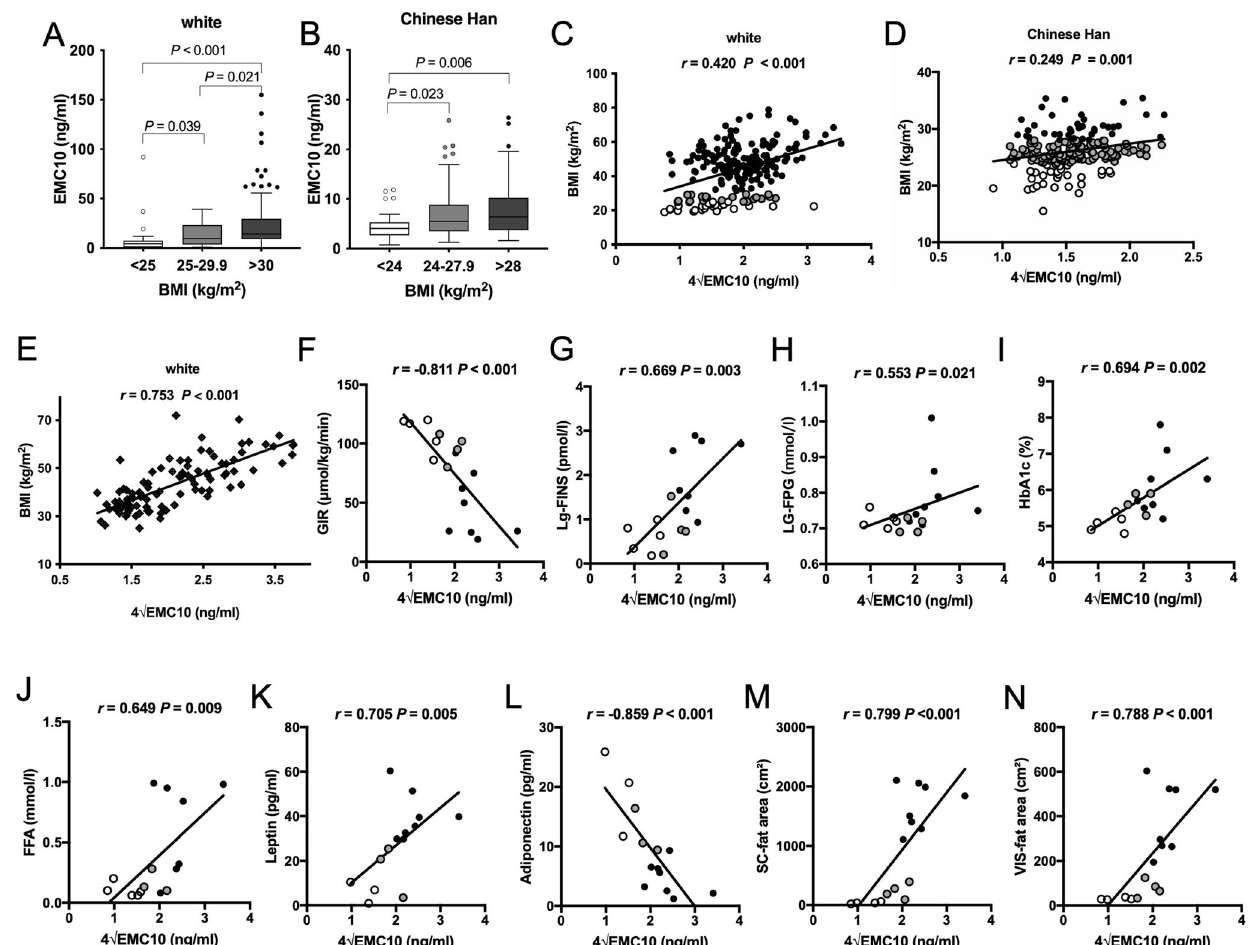
Fig. 1 | Serum EMC10 levels in white and Chinese Han cohorts. A Serum EMC10 levels in white human study participants with leanness ( n =27), overweight ( n =20)andobesity( n =160). B SerumEMC10levelsinChineseHanhumanstudy participants with leanness ( n =32), overweight ( n =115) and obesity ( n =39). Serum EMC10 levels are presented as box (median with interquartile range) and whisker (1.5x interquartile range) plots. Comparisons among 3 groups of parti- cipants were performed by one-way ANOVA with Fisher ’ s post hoc test, and then multiple comparisons were performed using LSD-t test. A two-sided P -value of <0.05 was considered as signi fi cant. C Correlation of serum EMC10 levels with BMIinthewhitecohortshowninpanel A ( n =207). D CorrelationofserumEMC10